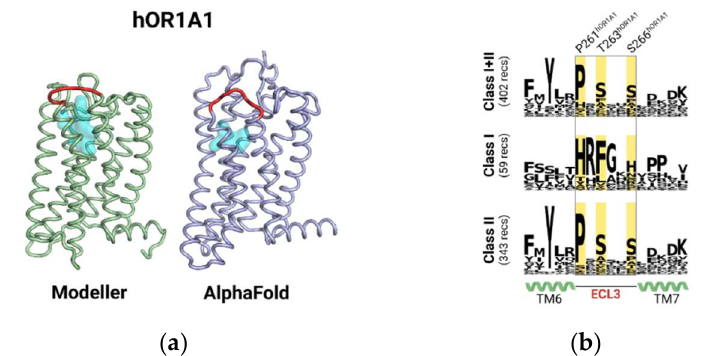
Figure 1. ( a ) Structure of hOR1A1 from homology modeling (Modeller) compared to that obtained from AlphaFold2 (AlphaFold). In both structures, the third extracellular loop (ECL3) (shown in red) was predicted to be close to the orthosteric binding cavity, shown as a cyan surface. ( b ) Conservation analysis of ECL3 sequences of both classes of human odorant receptors and the highlight of hOR1A1 specific ECL3